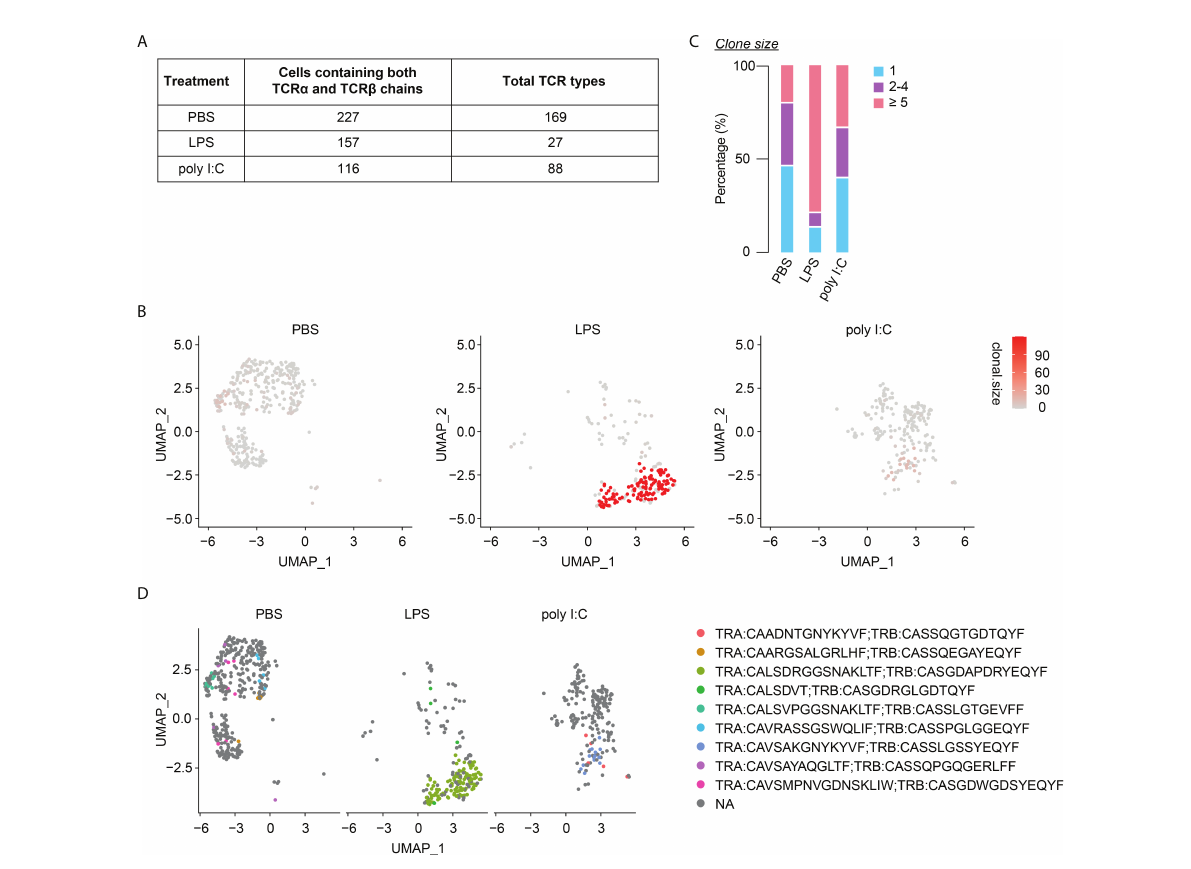
FIGURE 7 Diminished TCR diversity among neonatally-tagged Tregs 12 weeks post neonatal challenge. Newborn Foxp3 eGFPCreERT2 xROSA26 STOP-eYFP mice were intraperitoneally injected with LPS, poly I:C or PBS as control, followed by repetitive intragastric injections of tamoxifen at days 2, 5 and 8 after birth. Twelve weeks later, YFP + cells were FACS-sorted and subjected to combined scRNA/TCR-seq. (A) Table of total TCR clonotypes detected among splenic YFP + cells with paired TCR a and TCR b chains detected in PBS-, LPS- and poly I:C-treated mice. (B) UMAP plots depict the clonal size in splenic YFP + cells. (C) Bar plot summarizes frequencies of cells with unique (n = 1) or clonal TCR (n = 2-4 and n ≥ 5). (D) Splitted UMAPs depict clonotypes detected in clonal YFP + cells (n ≥ 5). UMAP, uniform manifold approximation and